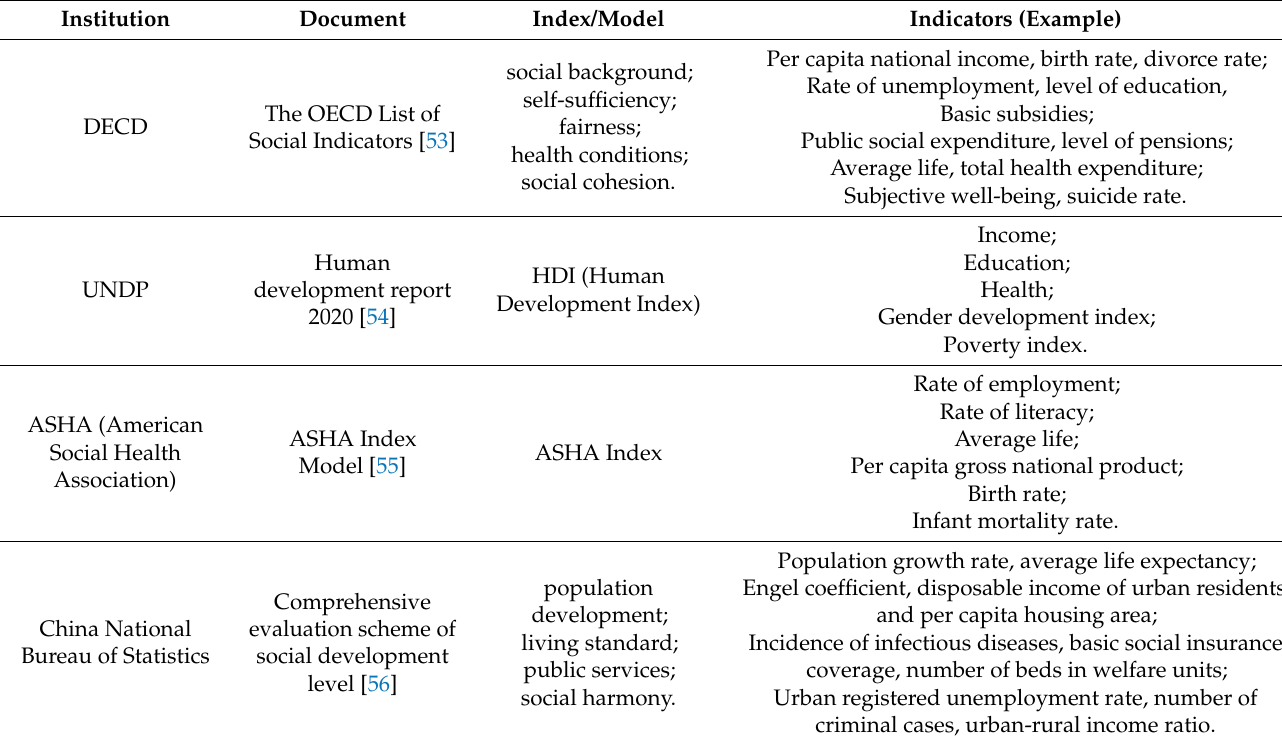
Table 2. Evaluation indicators of social development level in different countries/organizations.